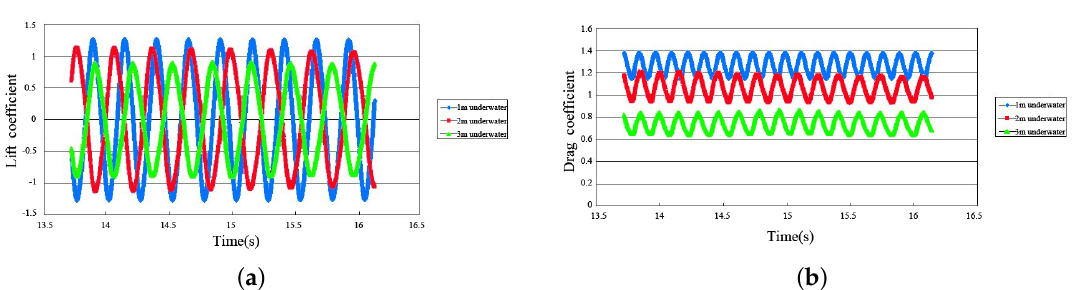
Figure 13. Contrast curves of SCR lift and drag coefficients at different underwater depths: ( a ) contrast curve of SCR lift coefficient at different water depths; ( b ) contrast curve of SCR drag coefficient at different water depths.